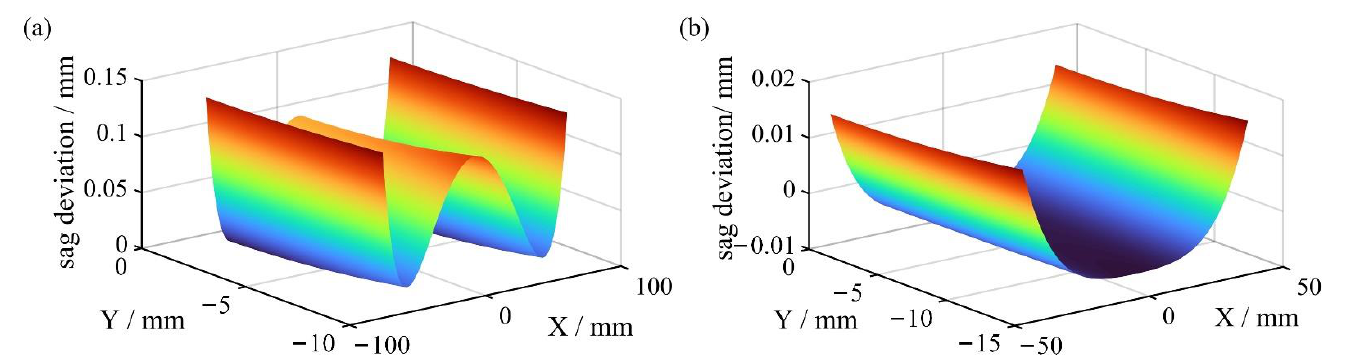
Figure 11. Sag deviation from the best-fit sphere: ( a ) PM , ( b ) SM .